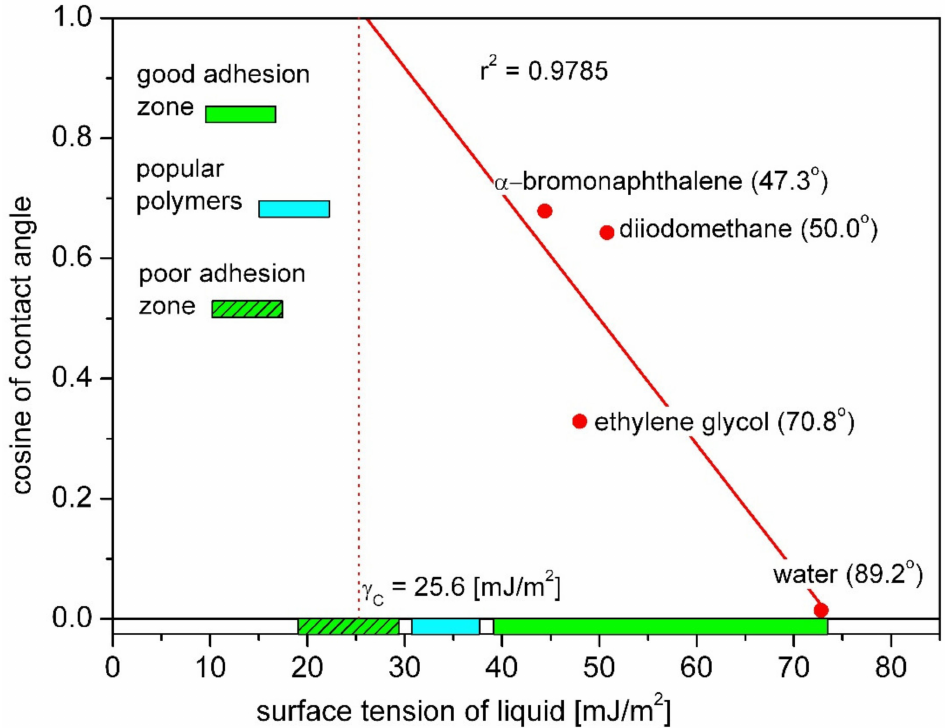
Figure 3. Zisman’s plot for PTFE with obtained value of critical surface free energy. Zones of surface energy were marked green according to